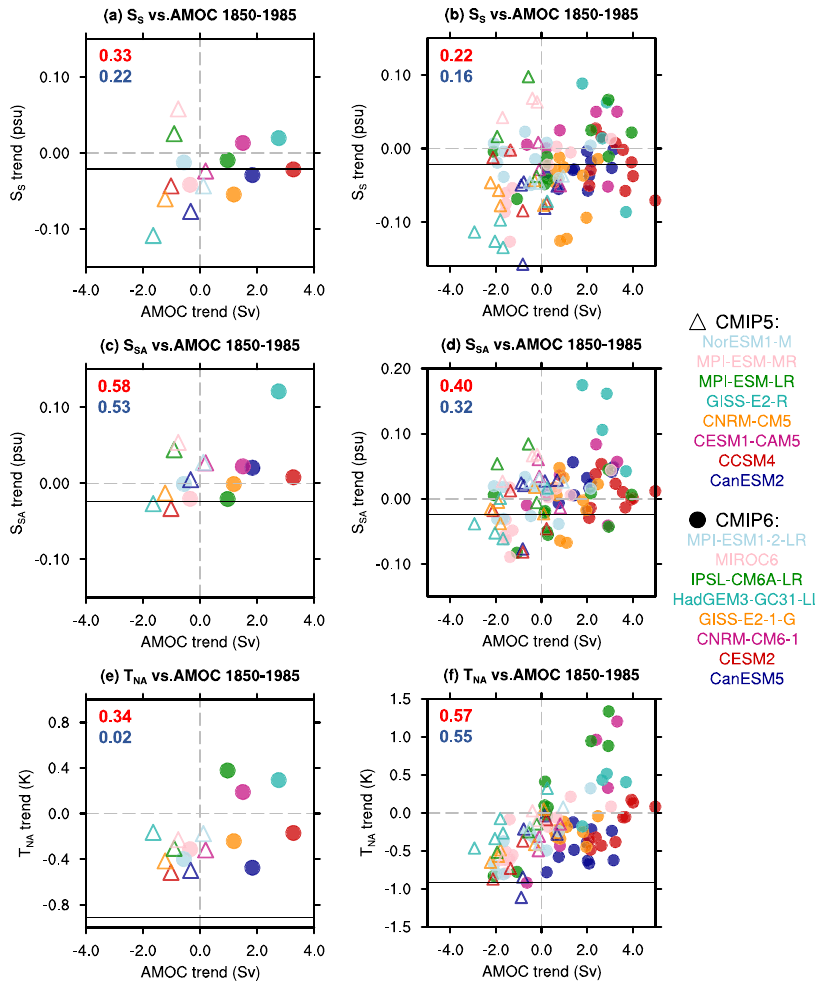
Fig. 2 | Trend correlation between Atlantic meridional overturning circulation (AMOC)indicesforperiod1850 – 1985.a ScatterfortrendsofAMOCintensityand its salinity-based fi ngerprint S S across model ensemble means. Trends are calcu- lated as the linear change from 1850 to 1985; ( b ) same as ( a ) but across model members.( c, d )sameas( a,b )butforAMOCand thesalinity-based fi ngerprintS SA ;